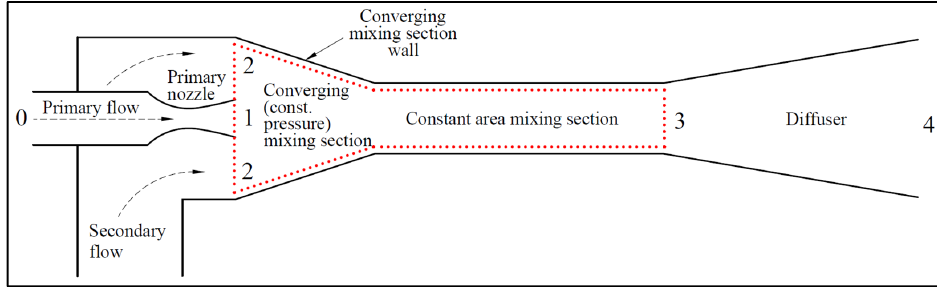
Figure 12. The dotted (red) and dashed (blue) lines are showing control volumes D and E, respectively. For control volume A shown in Figure 10, the mass and energy balance will be applied. The mass balance will result in Equation (5). 𝑚(cid:4662) (cid:2872) = 𝑚(cid:4662) (cid:2871) = 𝑚(cid:4662) (cid:3043) + 𝑚(cid:4662) (cid:3046) = ( 1 + 𝐸𝑅 ) 𝑚(cid:4662) (cid:3043) (5) where 𝐸𝑅 stands for entrainment ratio and defined as